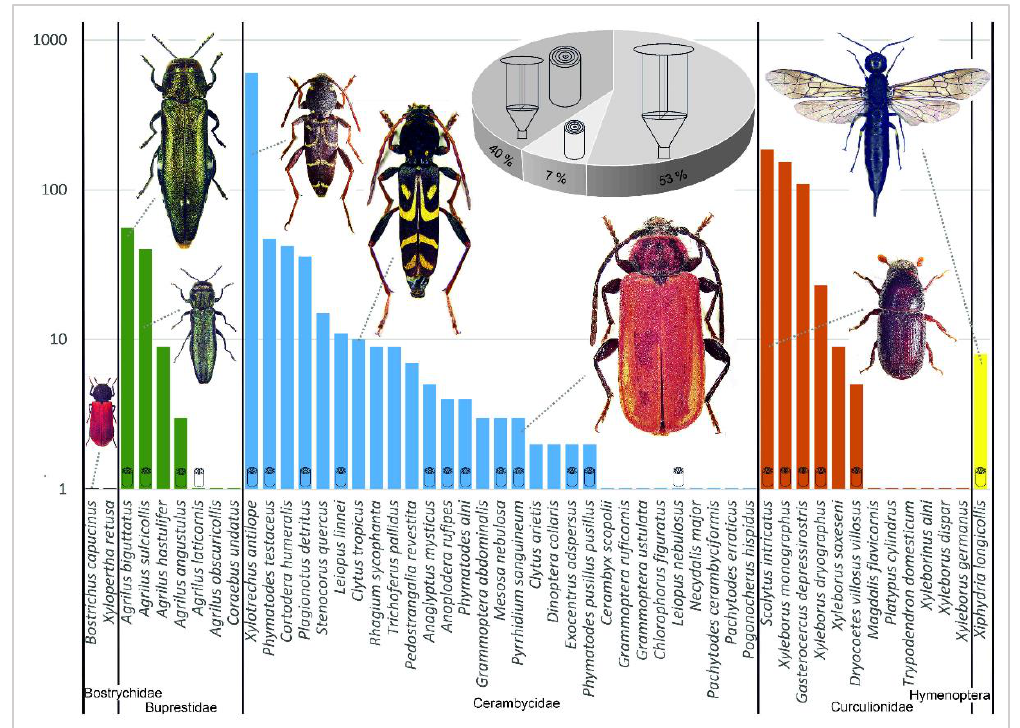
Figure 4. Subcortical insects captured in window traps. Individual species are grouped by family. The y -axis represents the logarithmic number of records for each species. Pie chart represents percentages for the number of species captured in each trapping method and by both methods together.